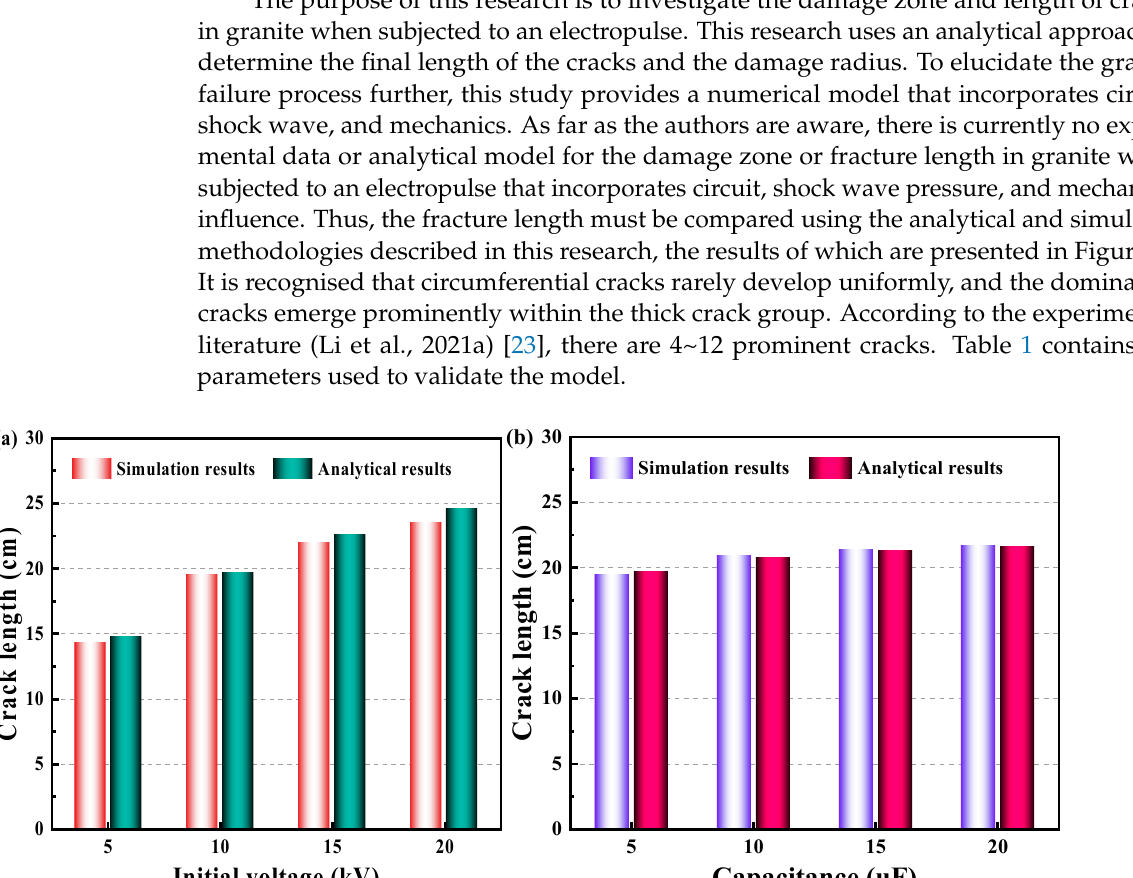
Figure 14. Validation of this paper’s results against the experiment results from Park et al. (2011) [49] for shock wave pressure. ( a ) Chamber diameter: 110 mm ( b ) Chamber diameter: 250 mm.